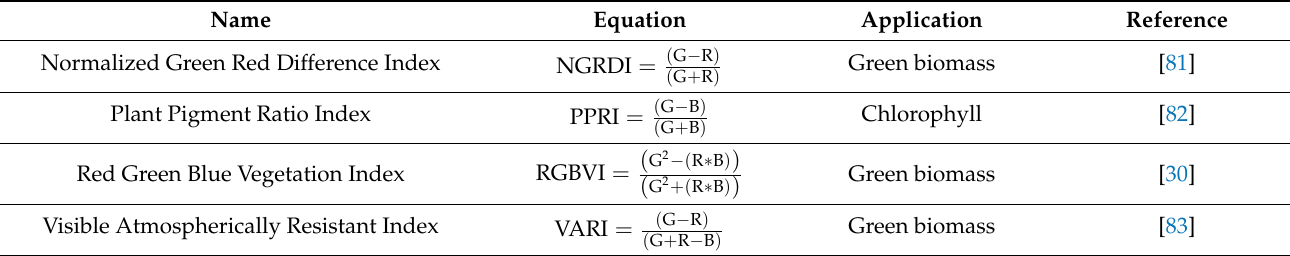
Table 3. Vegetation indices derived from the visible spectral region.